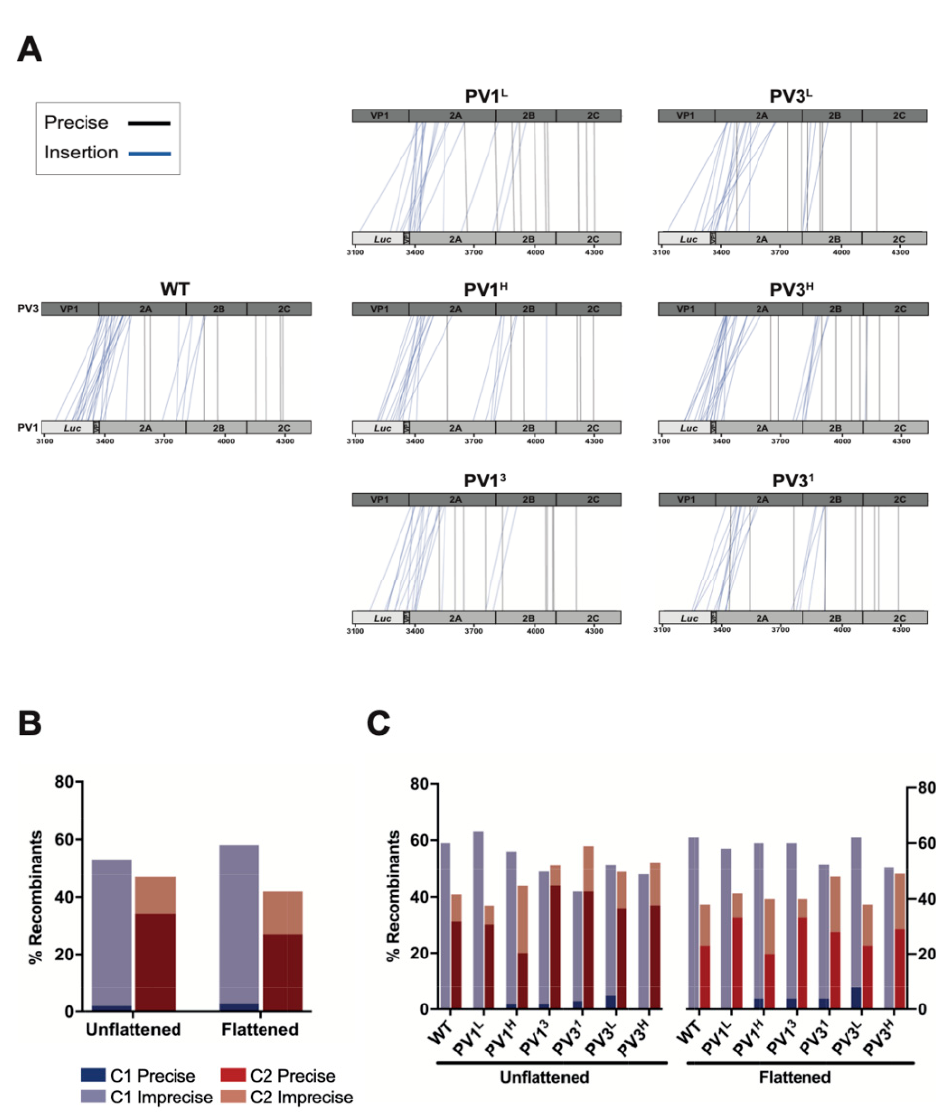
Figure 2. Analysis of recombination junctions from CRE-REP assay. ( A ) The location of each recom- bination junction was mapped respective to each parental genome. Each line represents a unique recombinant within the population of precise (black) or imprecise-insertion (blue) recombinants (see